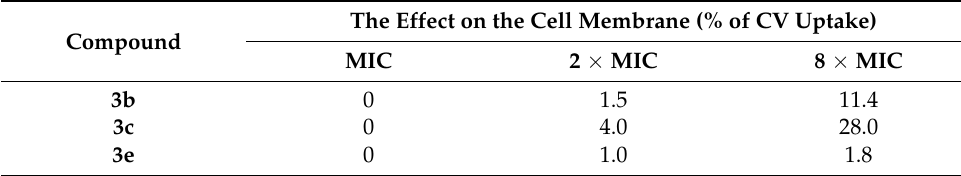
Table 6. The effect of compounds on the cell membrane of C. albicans ATCC 10231. The Effect on the Cell Membrane (% of CV Compound